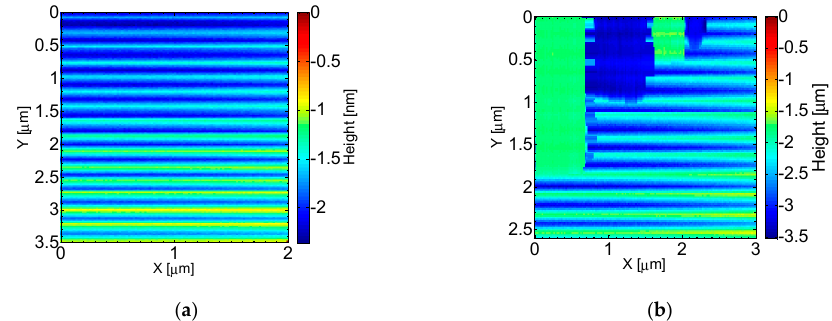
Figure 10. Simulation results of periodic surface profiles for t delay = 4 ps ( a ) and t delay = 10 ps ( b ). Results are illustrated in a quadrant. Results are for (001) TiO 2 . Double–ended arrow indicates laser polarisation direction.